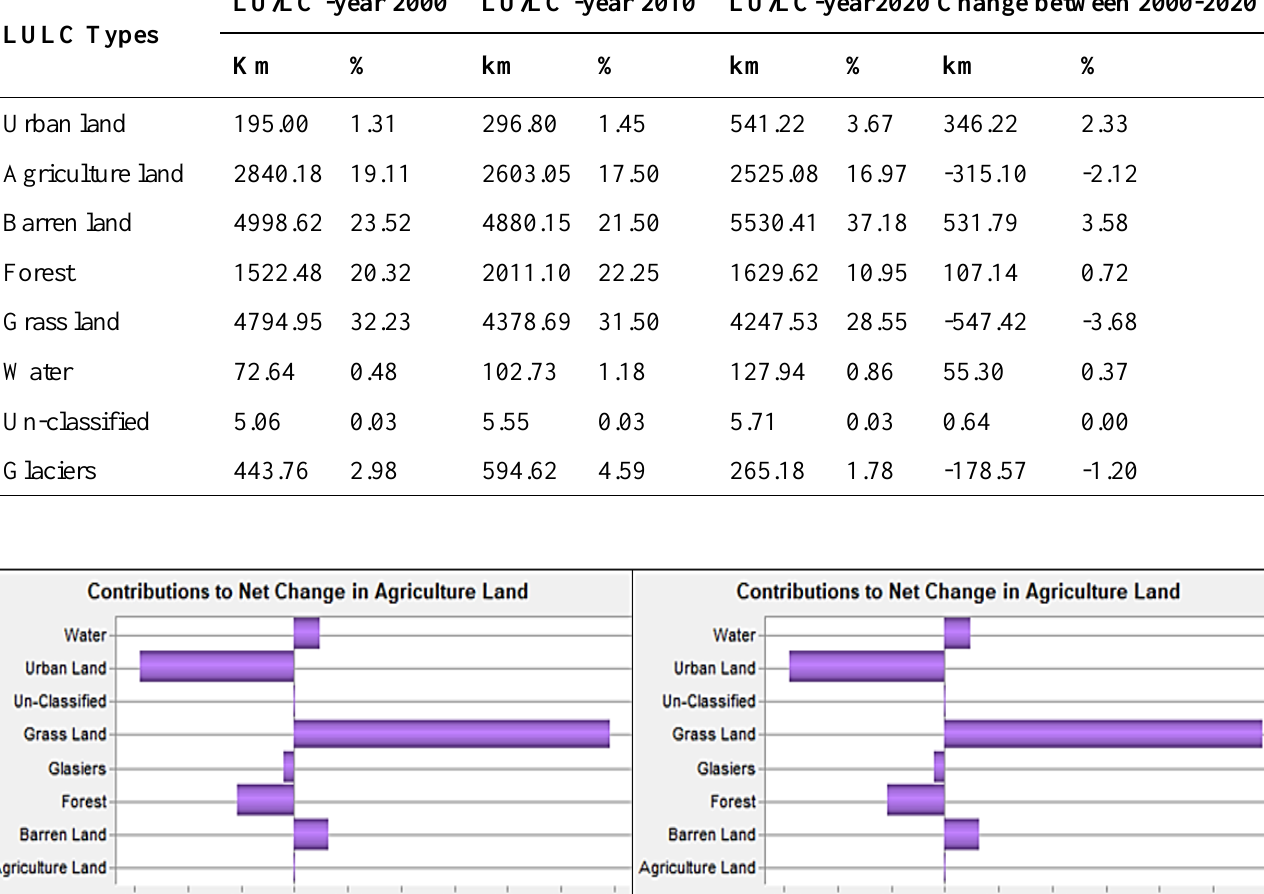
Table 5. The area coverage of LULC, percent, and rate of changes between 2000, 2010, and